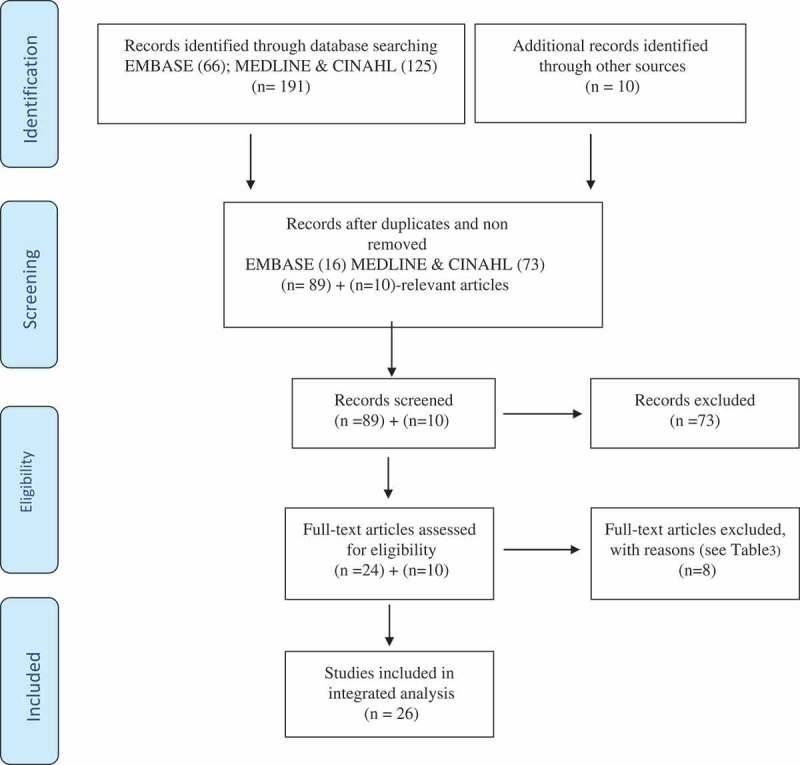
PRISMA Diagram.Moher et al. [72].